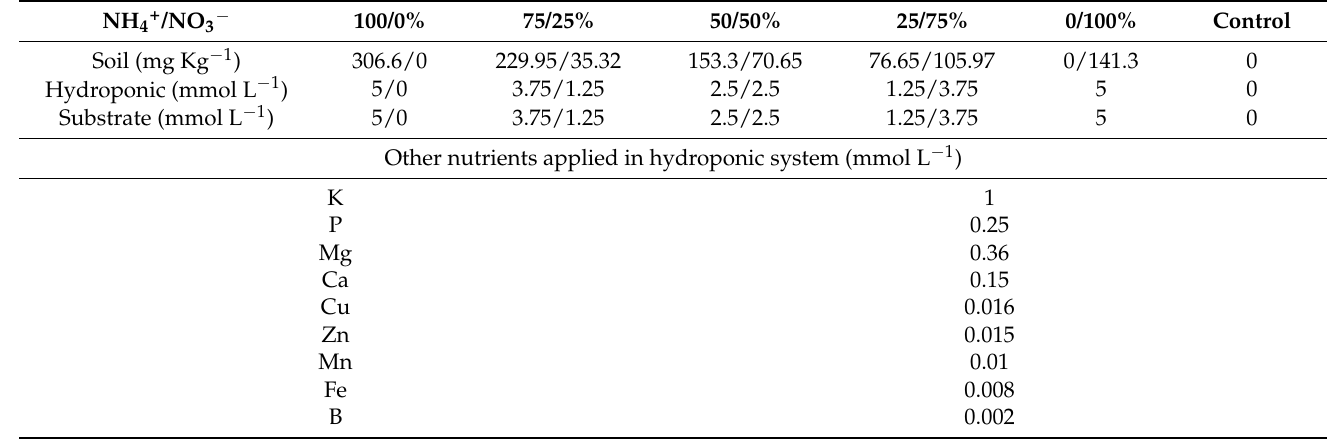
Table 2. Nutrient application in soil, substrate and hydroponic cultivation